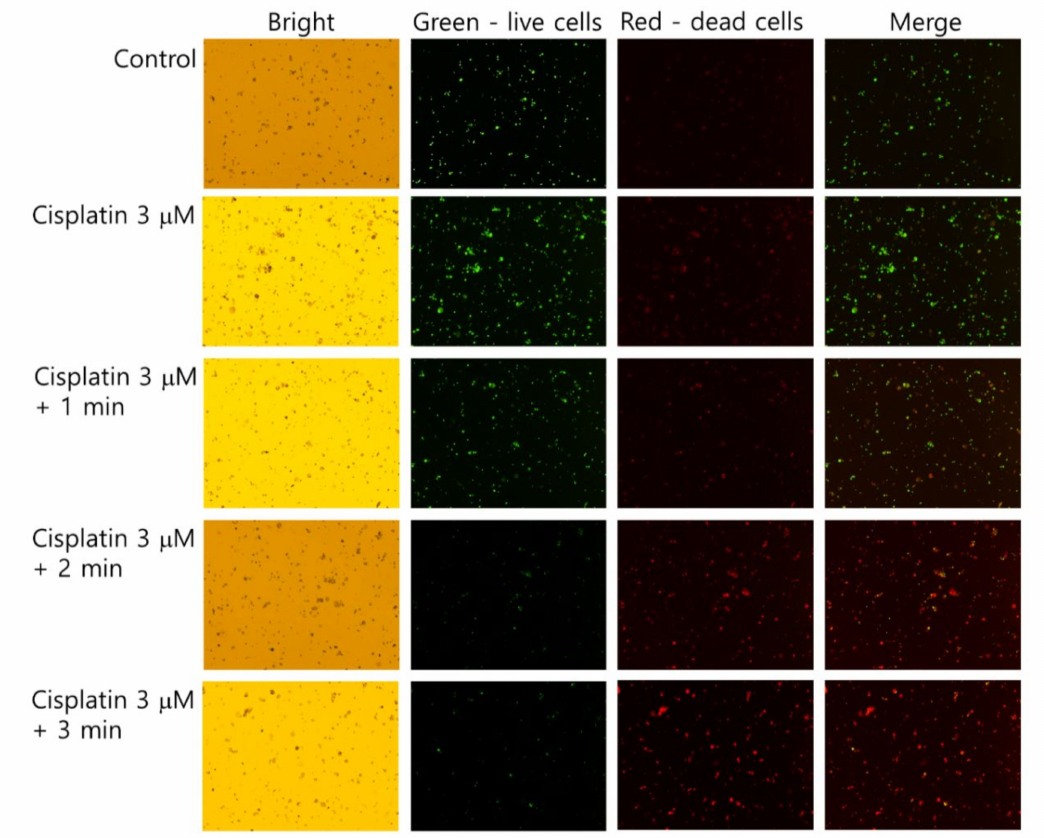
Figure 6. Live and dead cell staining. SCC-15 cells and HGF-1 cells were treated with cisplatin and CAP, as described in Figure 4. Cells treated with cisplatin / CAP were harvested and then stained with a live / dead cell staining solution. Green and red represent live and dead cells, respectively. (Magnification: 40 ×